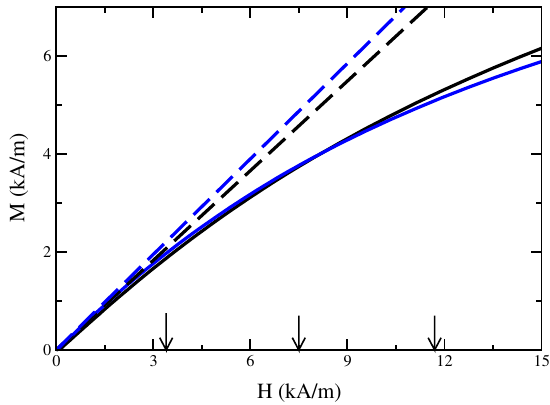
Figure 2. Experimentally measured magnetisation curve of EMG 909 (black solid line) and APG S21 (blue solid line), respectively, in the relevant range of H . Courtesy of K. May [17]. The black long-dashed (blue long-dashed) line indicates a linear law of magnetisation with χ = 0.61 ( χ = 0.65) for EMG 909 (APG S21). The vertical arrows indicate the strength of the magnetic field at the rim of the wire at R = 0.95 mm for I = 20 A, 45 A and 70 A (from left to